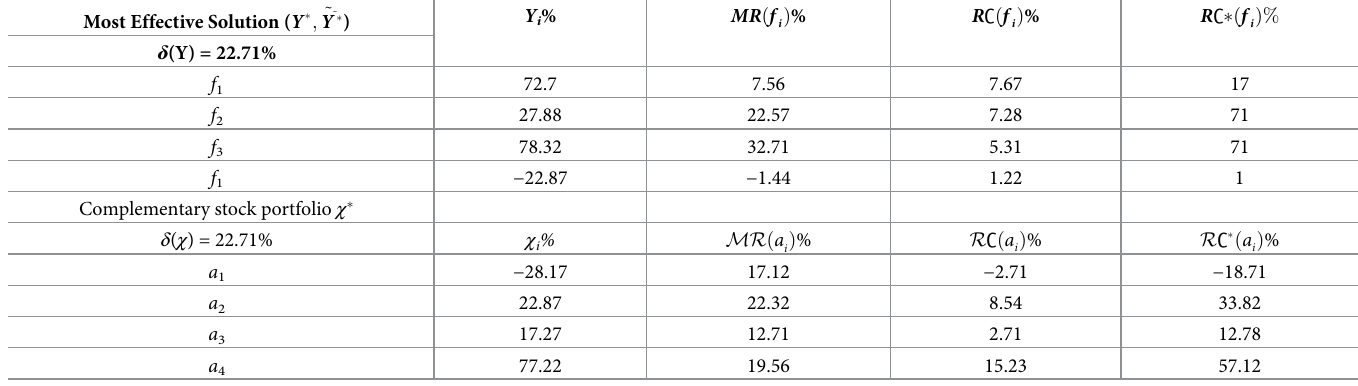
Table 2. Creating a match between the risks budgets (48%, 26%, 25%). Most Effective Solution ( Y � ; ~ Y ~ � )